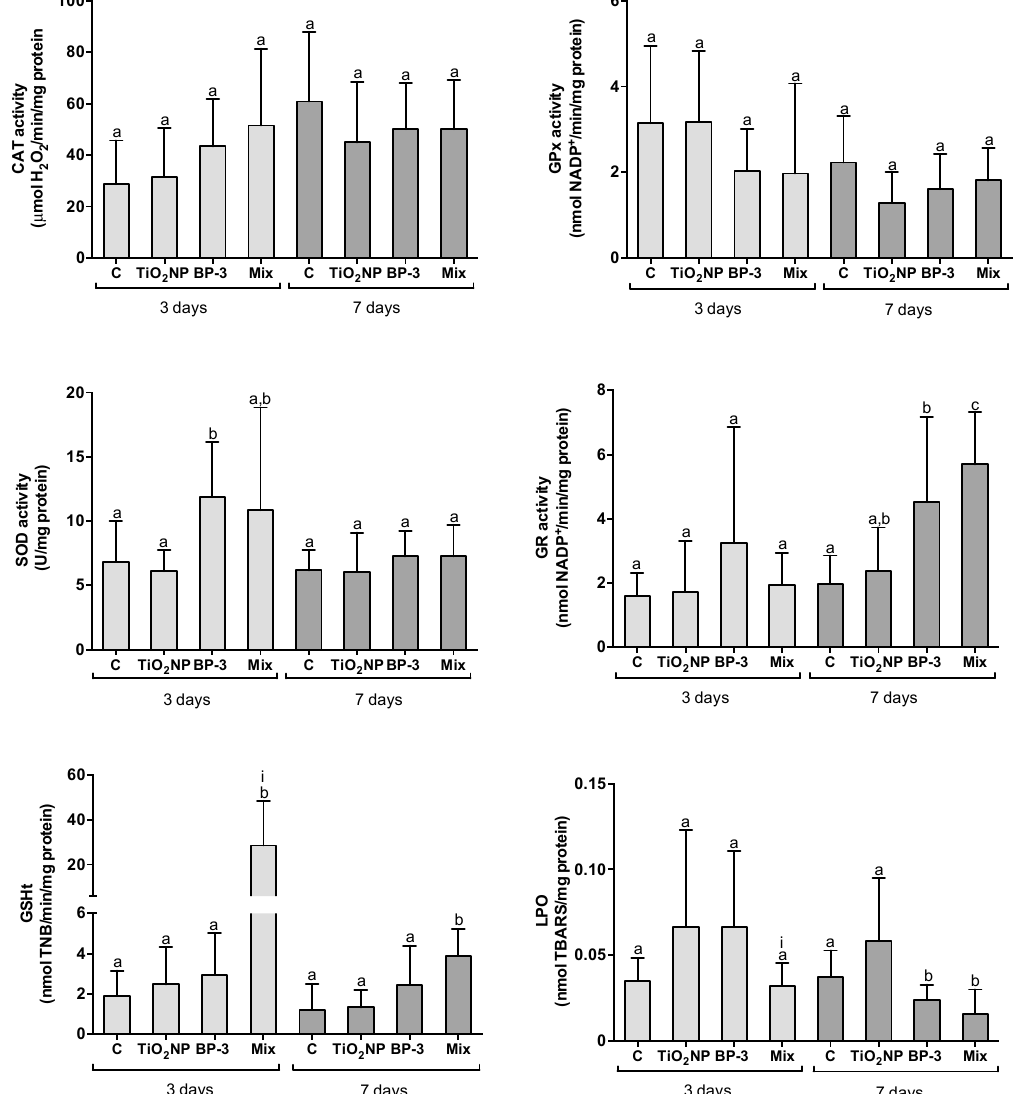
Figure 4. Oxidative stress responses in the liver of S. maximus , 3 and 7 days after intraperitoneal injection of titanium dioxide nanoparticles (TiO 2 NPs; 3.0 µ g TiO 2 NP per g fish weight), oxybenzone (BP-3; 3.0 µ g BP-3 per g fish weight) or their mixture (Mix), as well as the respective control group (C). Different lower-case letters denote significant differences ( p < 0.05). Significant interaction between TiO 2 NPs and BP-3 is depicted by (i) ( p < 0.05). Columns correspond to mean and error bars represent the standard deviation.